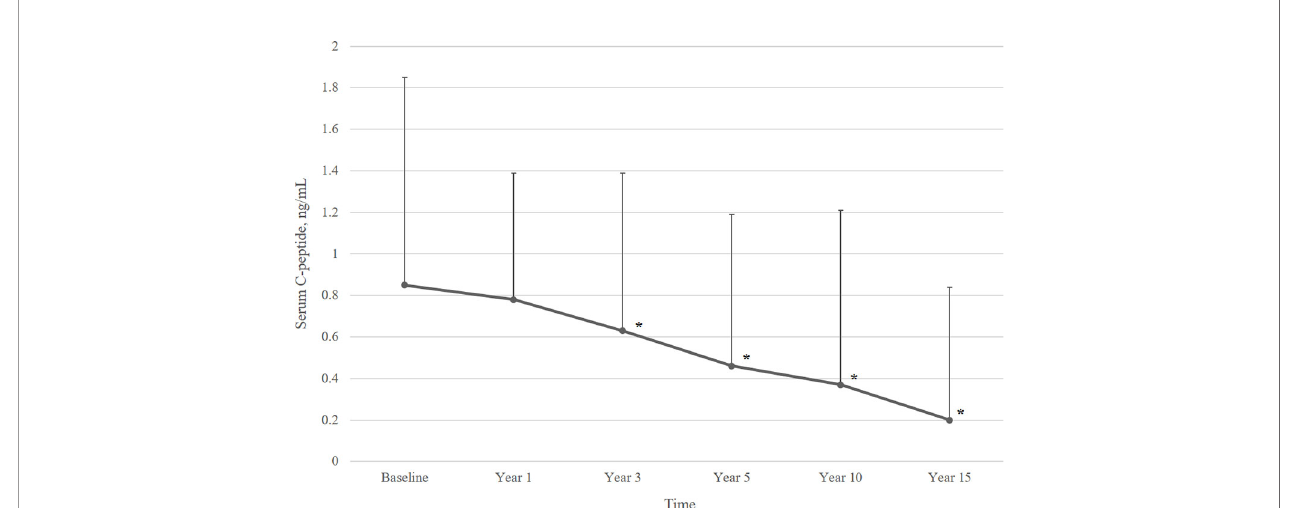
FIGURE 2 | Mean serum C-peptide levels over 15 years of follow-up. Data are presented as mean ± SD. Overall p value <0.001. *p<0.05, compared to baseline serum C-peptide level.